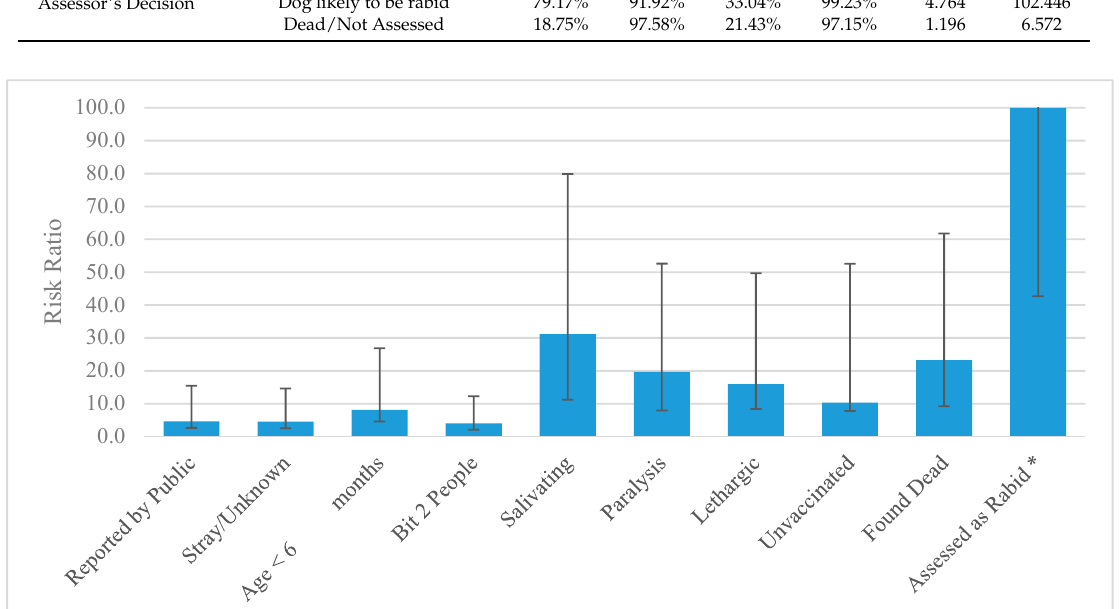
Figure 1. Risk ratio of significant variables and their 95% CI. * “Assessed as rabid” has a RR = 413 and 95% CI upper limit = 2985. For ease of comparison to other variables in this figure, it is limited to RR = 100 and no upper limit is shown.